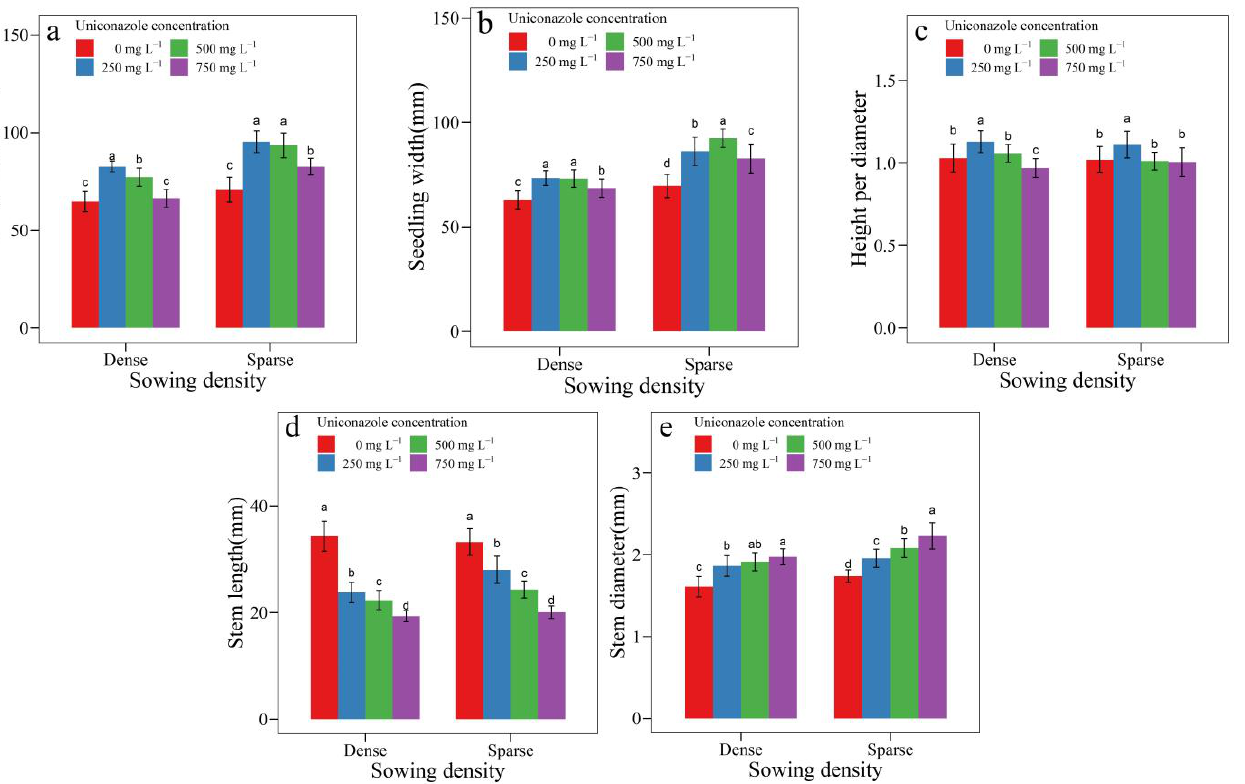
Figure 1. The effect of uniconazole on seedling architecture in two sowing densities. Values are the seedling architecture measured at 30d of seedling height ( a ), seedling width ( b ), height per diameter ( c ), stem length ( d ), and stem diameter ( e ). Sparse and dense represent sowing densities of 400 and 800 seeds per tray, respectively. Significant effects ( p ≤ 0.05) are shown by different letters in the same sowing density.